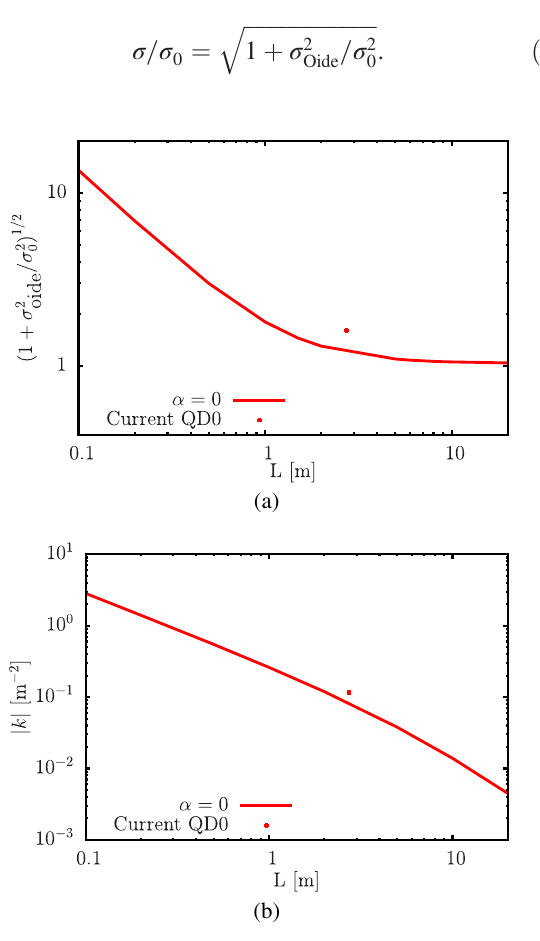
FIG. 2. Oide effect beam size contribution for CLIC 3 TeV design parameters. (a) Total beam size normalized to the designed linear beam size as a function of the quad length for the minimum focusing k and the current QD0. (b) k in the two previous